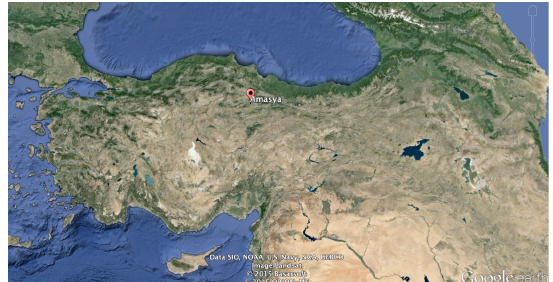
Figure 1. Location of Amasya - Turkey